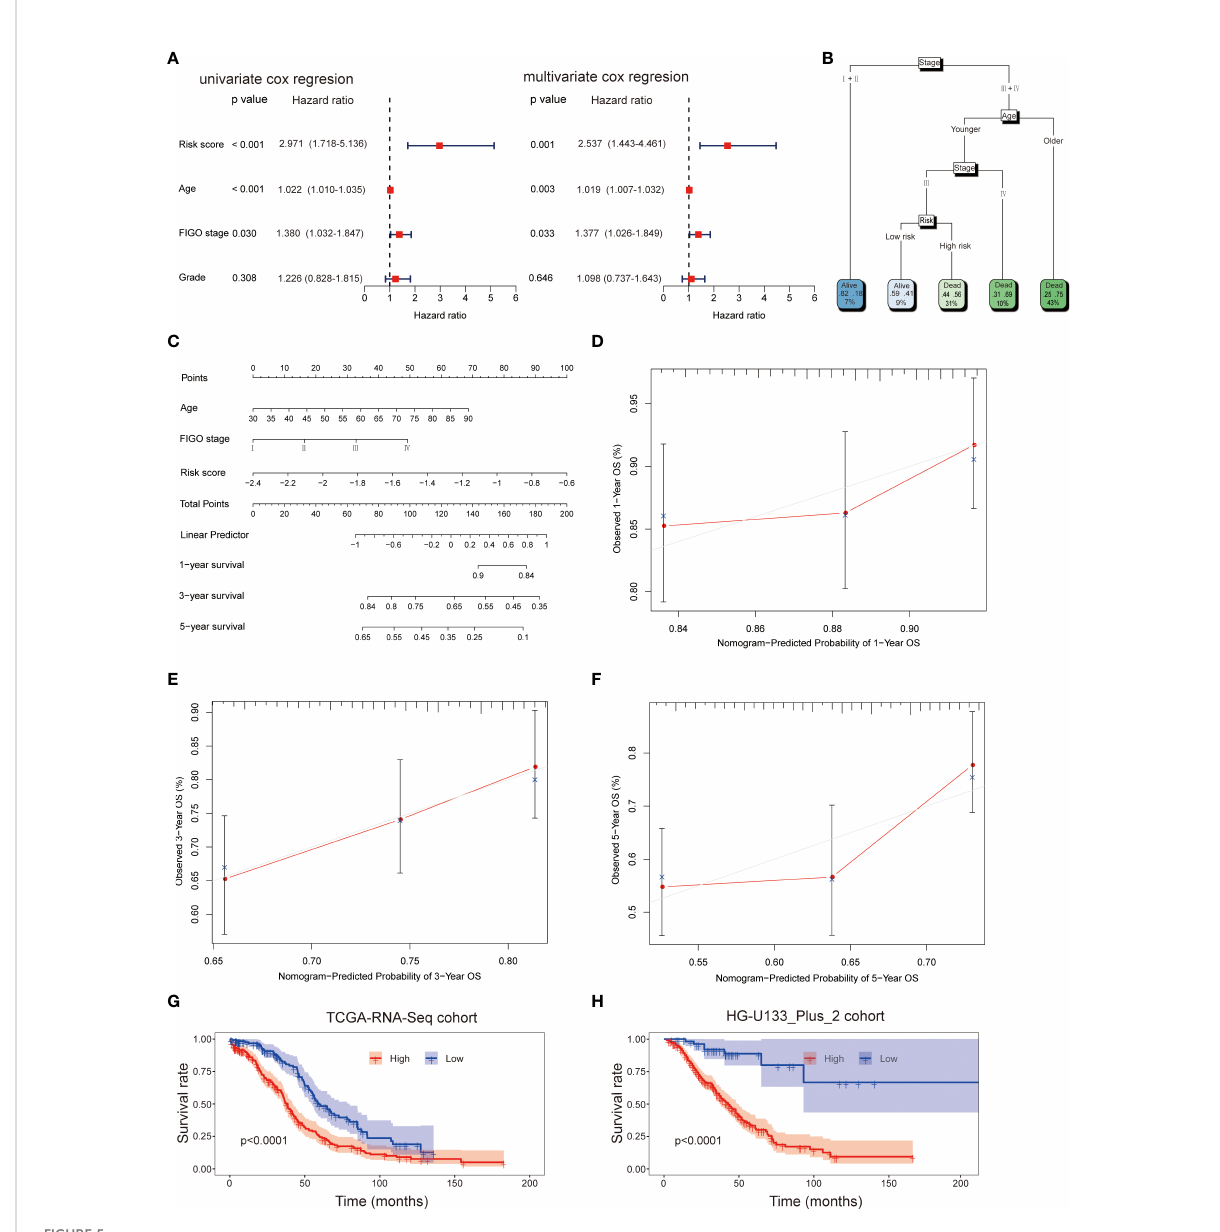
FIGURE 5 Univariate and multivariate analyses revealed that risk score was an independent prognostic predictor in the TCGA-RNA-Seq cohort (A) . Construction of decision tree based on risk score, age and stage. The younger and older subgroup were divided based on the median value of age (B) . Construction of nomogram based on risk score, age and stage (C) . Calibration plots of the nomogram for predicting the probability of OS at 1, 3, and 5-years in the TCGA-RNA-Seq cohort (D – F) ; KM survival plot analysis showed that patients with high-risk had a worse OS than patients with low-risk subgroup in both TCGA-RNA-Seq cohort and HG-U133_Plus_2 cohort (G, H)